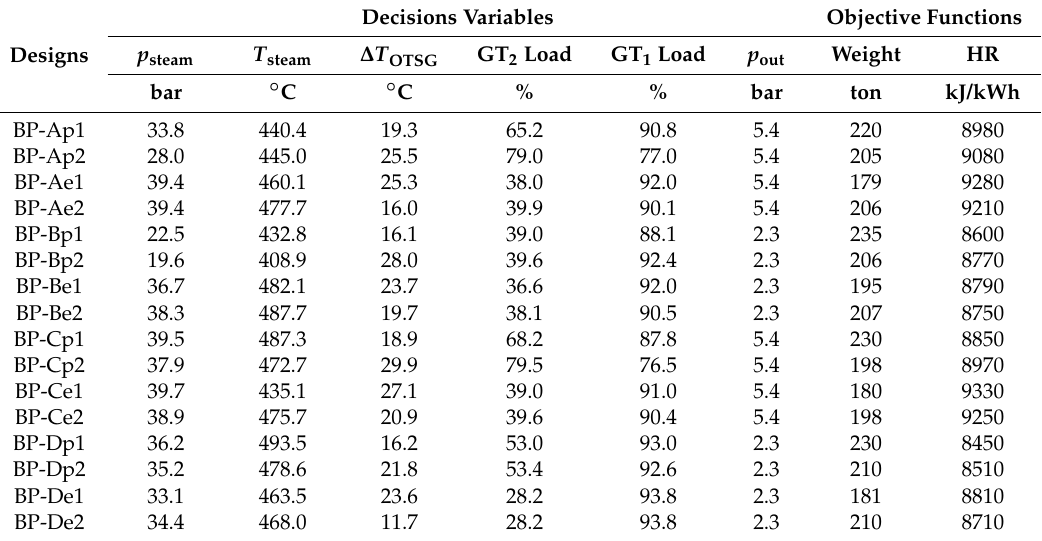
Table 4. Main characteristics of the designs defined for the backpressure steam turbine